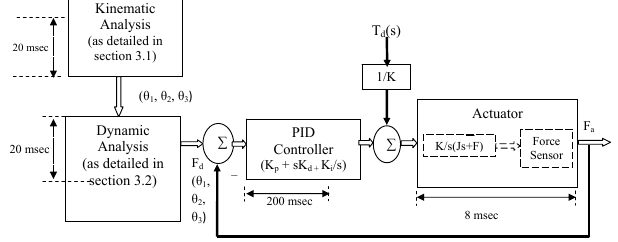
Kinematic Analysis (as detailed in section 3.1)